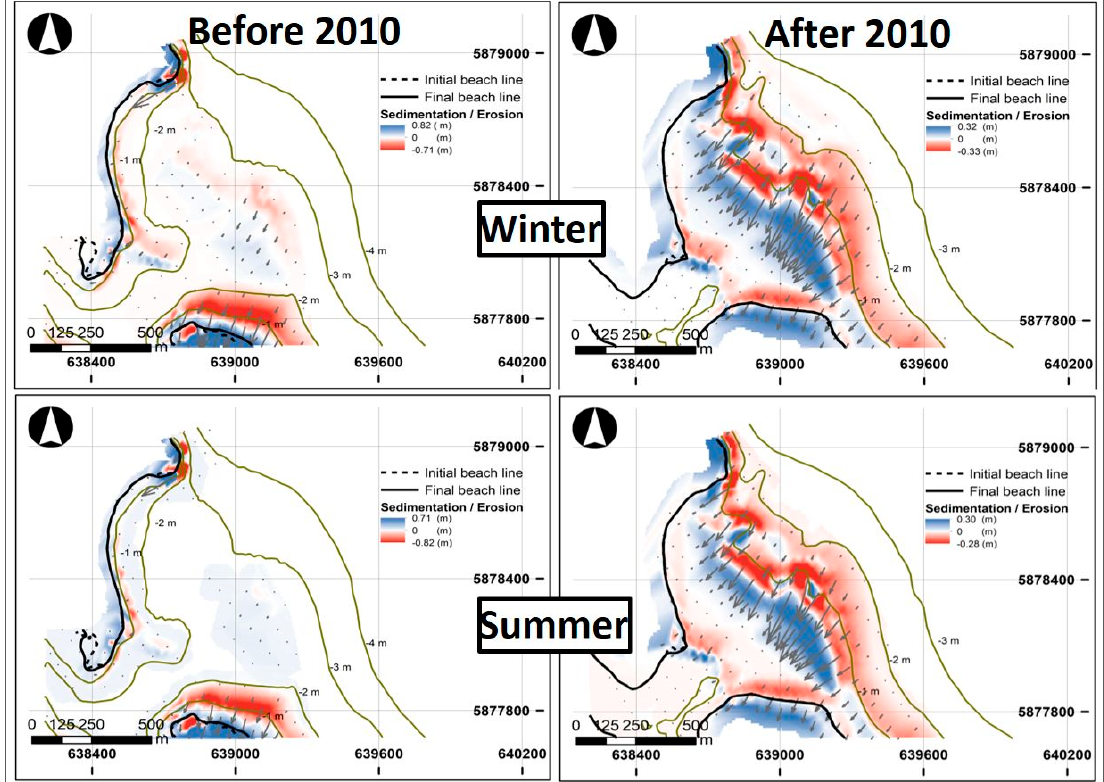
Figure 13. Morphological response of Tubul Beach before and after the 2010 earthquake (uplift of 1.4 m): upper left, before 2010, winter waves; lower left, before 2010, summer waves; upper right, after 2010, winter waves; lower right, after 2010, summer waves.